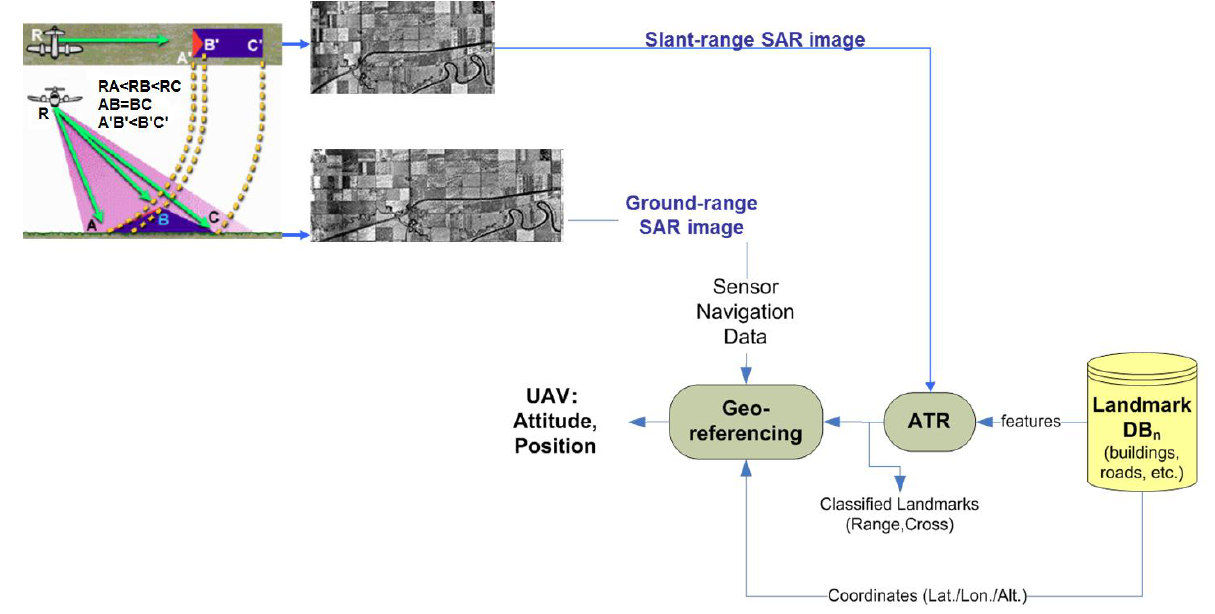
Figure 1. Whole ATR and SAR based geo-referencing concept: